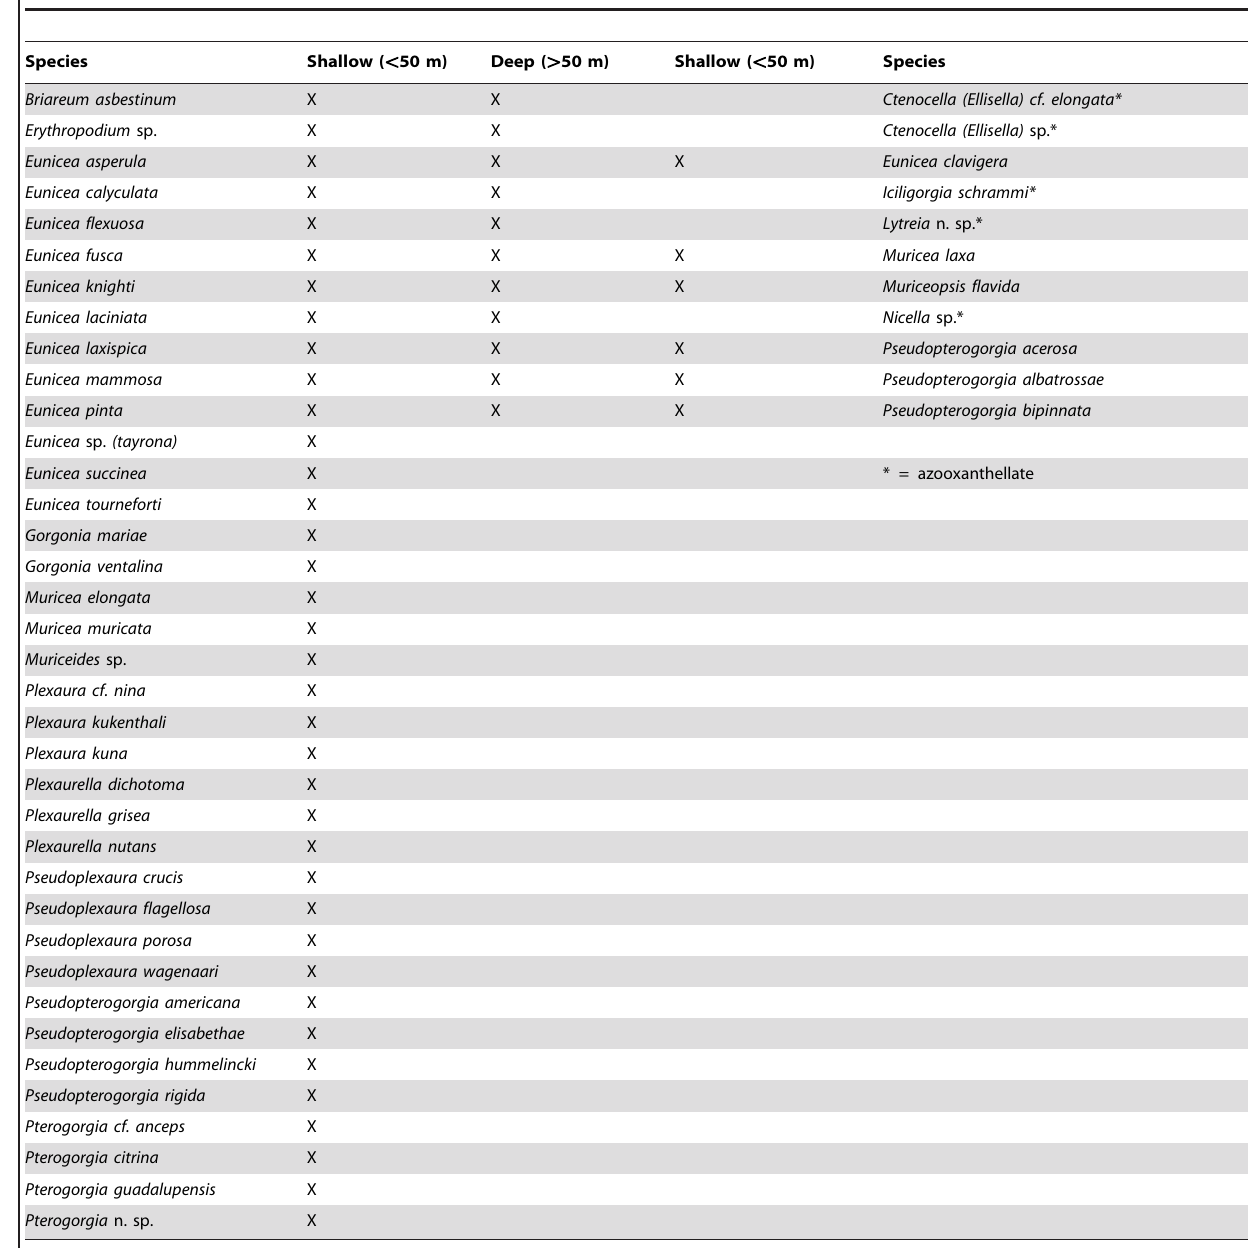
Table 1. List of octocoral species collected from Saba Bank.